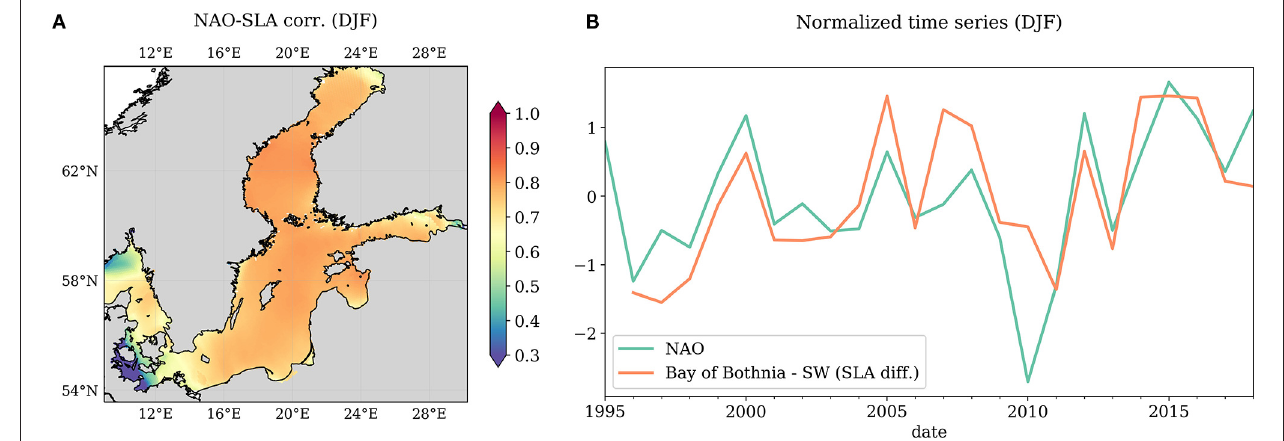
FIGURE 11 | (A) Correlation of the NAO index with SLA from gridded altimetry. (B) Normalized time series of NAO index (green) and SLA difference between Bay of Bothnia and S-W sub-basins (orange). Each point represents the time average of the quantities of the winter months December, January, and February.